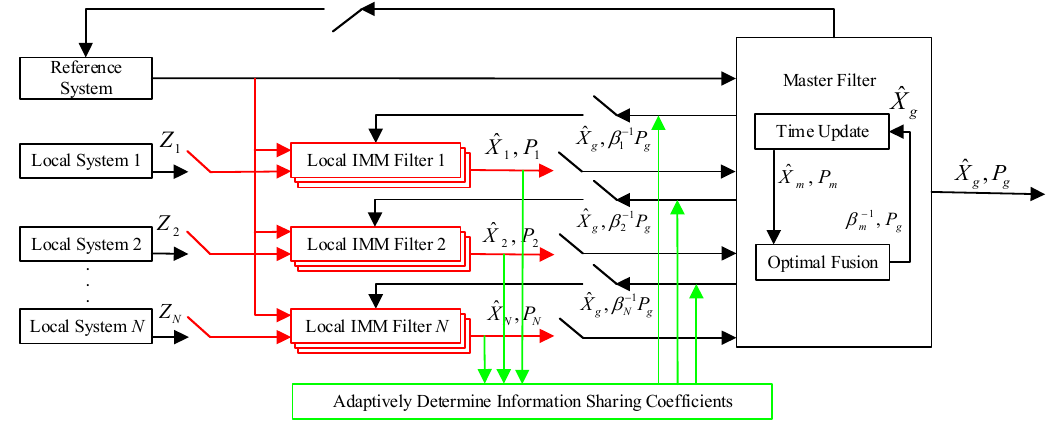
Figure 2. The schematic diagram of the adaptive Federated IMM filter.